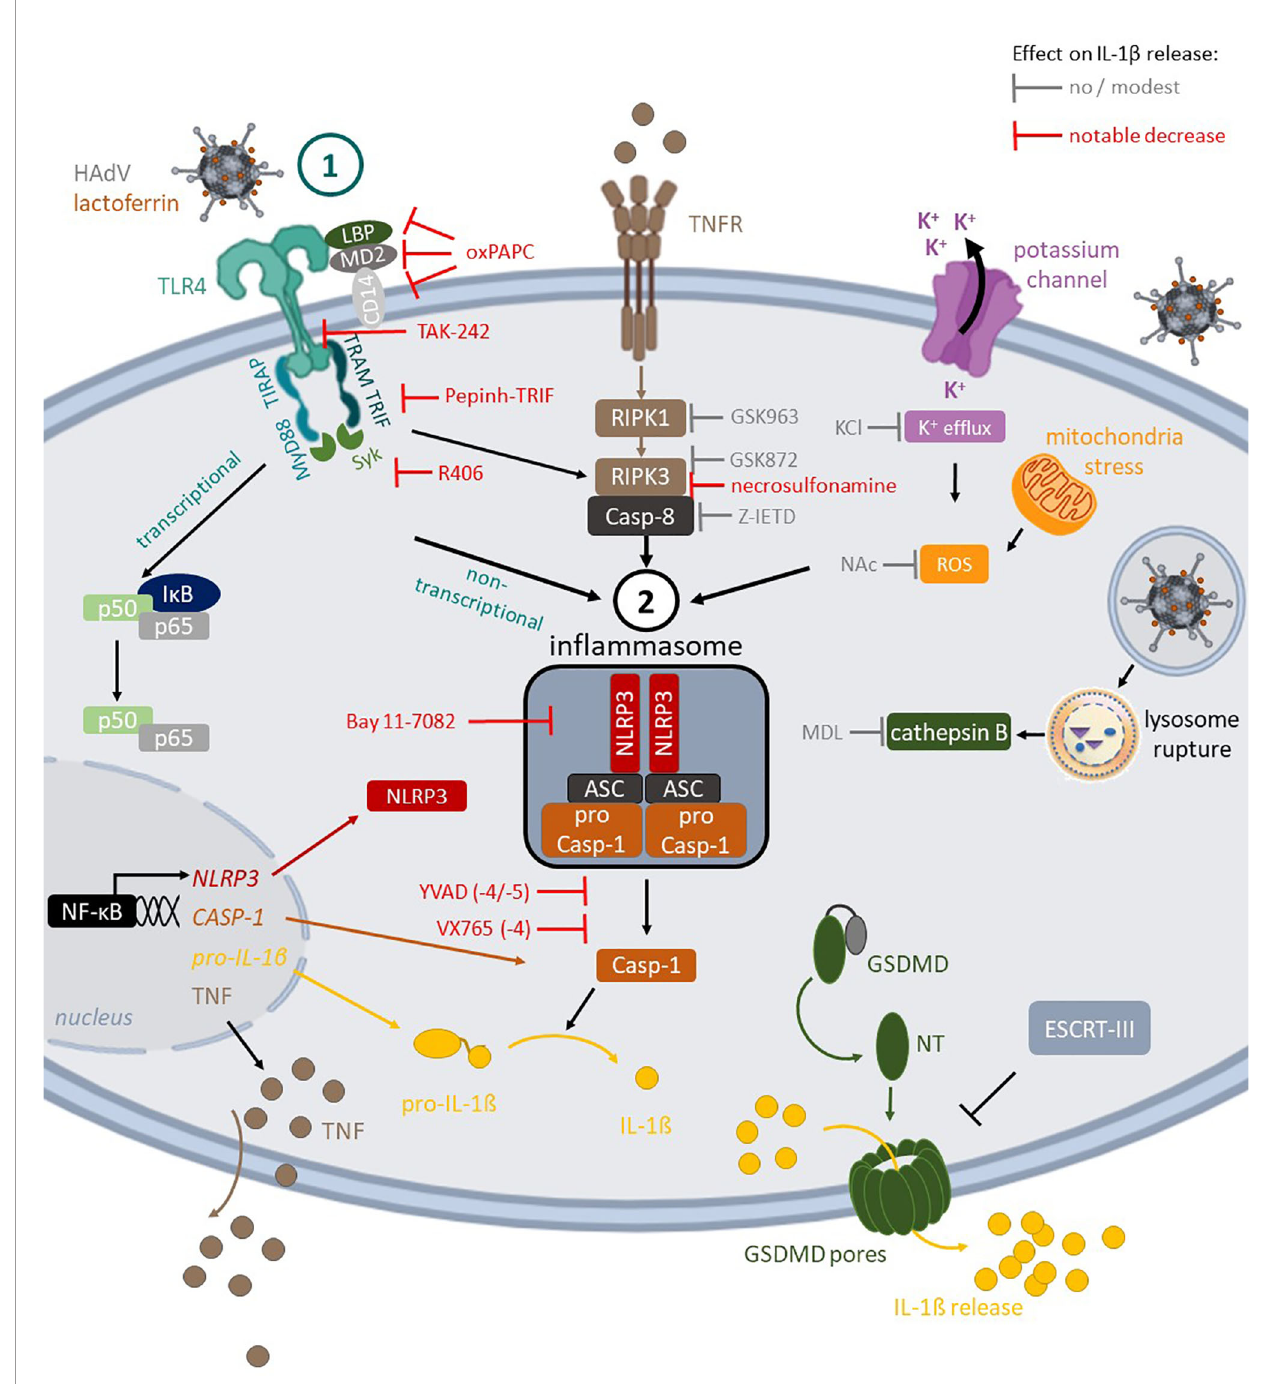
FIGURE 7 | TLR4-mediated HAdV-lactoferrin uptake in DCs and IL-1 b release Lactoferrin binds to HAdV capsid and retargets the capsid toward TLR4 complex on the cells surface. Following TLR4 engagement, its TIR domain recruits MyD88 and TIRAP, which bridge TLRs to IRAK and MAPK family members that activate NF- kB, AP-1, and IRF. This priming event initiates transcription of genes coding for in fl ammasome components (e.g., NLRP3 and IL-1 b ). Under prototypic conditions, DCs detect a second perturbation (signal 2) that induced ROS release (mitochondrial stress) or K + ef fl ux (perturbations of cellular integrity), and/or cathepsin B release from lysosome rupture. These pathways do not appear to be activated by HAdV-lactoferrin complexes. In addition to TLR4 pathways, the RIPK1-RIPK3 pathway is activated through an autocrine-TNF release. During in fl ammasome formation, pro-caspase-1 auto-activation induces cleavage of pro-IL-1 b and likely GSDMD, which will initiate, but not complete, the loss of plasma membrane integrity via pore formation, allowing IL-1 b release. Twenty-four hours post-challenge, DC membrane integrity is intact, consistent with the involvement of ESCRT-III complex and repairing GSDMD